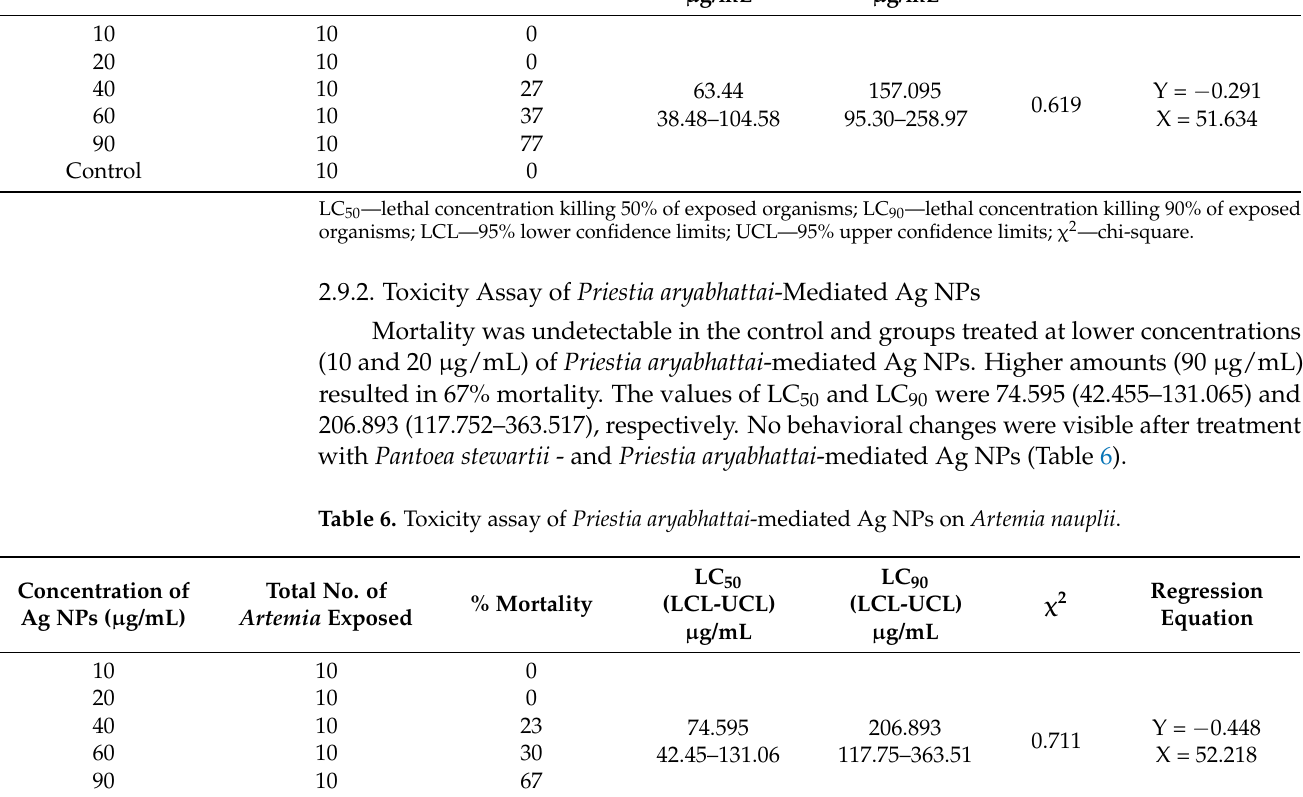
Table 5. Toxicity assay of Pantoea stewartii -mediated Ag NPs on Artemia nauplii . Concentration of